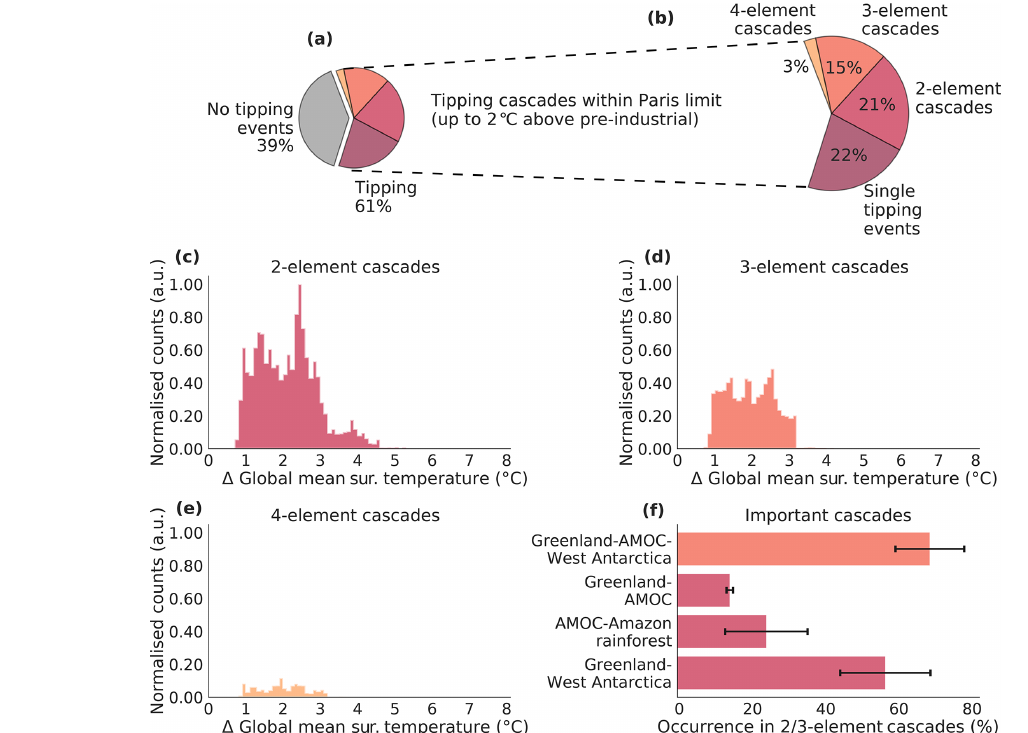
Figure 5. Tipping cascades for all interaction strengths between 0.0 and 1.0. (a, b) For global warming up to 2.0 ◦ C above pre-industrial levels, the coloured shading illustrates the fraction of model representations in the Monte Carlo ensemble without tipping events (grey), with a single tipping event (purple), and with cascades including two (red), three (dark orange) or four (light orange) elements. (c–e) Occurrence of tipping cascades with two, three or four elements as a function of global mean surface temperature increase. The counts are normalised to the highest value of the most frequent tipping cascade (in cascades with two elements). (f) Dominant cascades with two and three elements for temperature increases from 0 to 8 ◦ C above pre-industrial. Other cascades are not shown, as their relative occurrence is comparatively much smaller. The standard deviation represents the difference between the possible ensemble realisations of the interaction network (see Sect. 2.3). Hence, it tends to be larger for cascades where unclear interaction links are involved, e.g. for the AMOC–Amazon rainforest cascade (compare Fig. 1 and Table